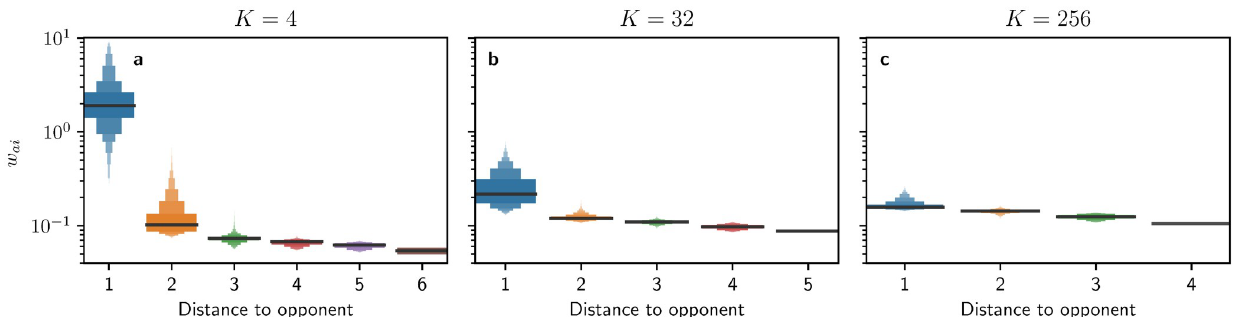
Fig 3. Depiction of the shielding heuristic. On the y axis, numerical optimal control allocations of the active controller in the form of a letter-value plot [50]. On the x-axis, shortest distance to a node targeted by the passive controller who targets a K = 4, b K = 32, or c K = 256 random nodes in the network in a discrete fashion. Different levels of a boxplot represent the median, quartiles, octiles, and so on, while containing points from 15 repeats of the experiment. The total budget of both controllers sums up to B þ B ¼ N h d i = 30 . a b